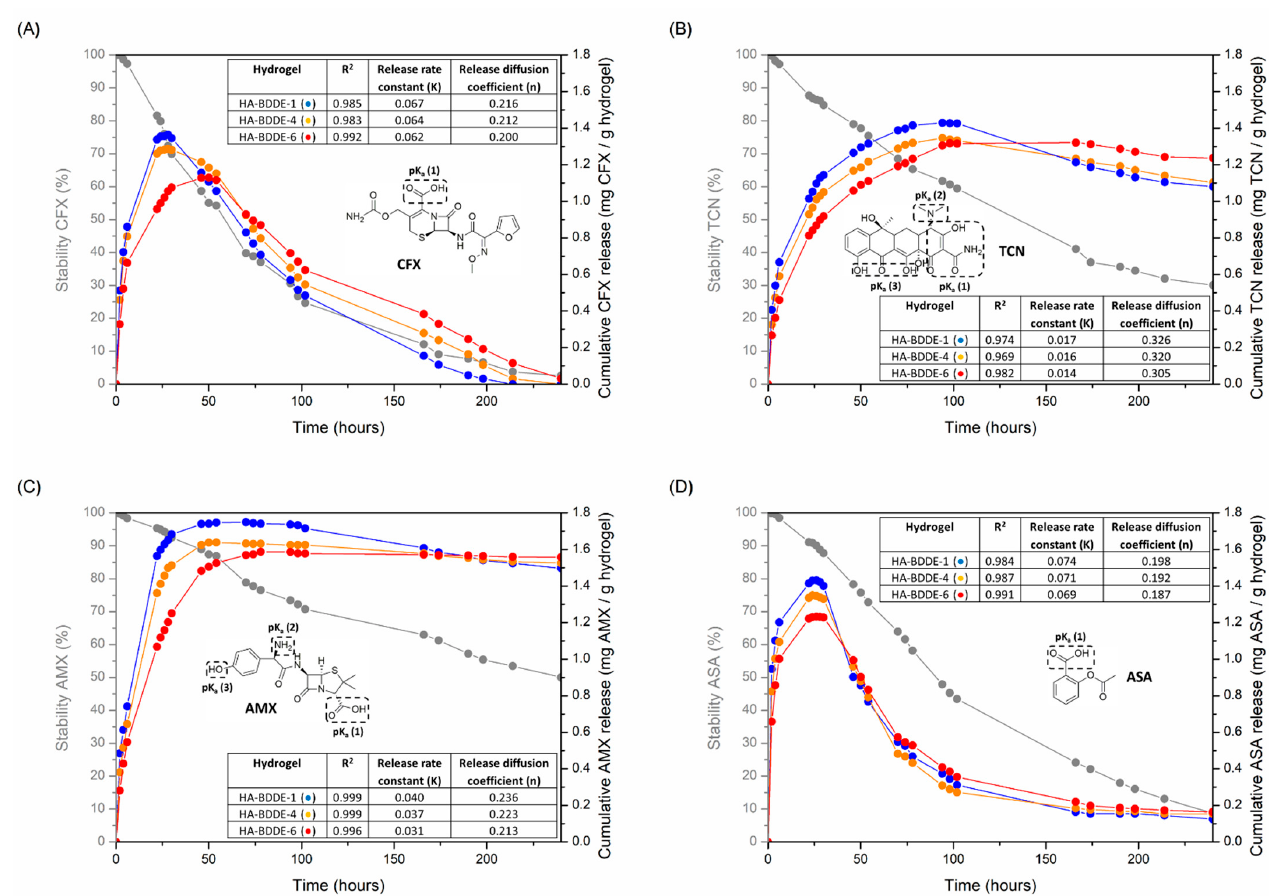
Figure 5. Release of ( A ) CFX, ( B ) TCN, ( C ) AMX, and ( D ) ASA from HA-BDDE-1 ( • ), HA-BDDE-4 ( • ), and HA-BDDE-6 ( • ) gels Release rate constant (K) and release diffusion coefficient (n) values measured by the Korsmeyer–Peppas model are also presented.